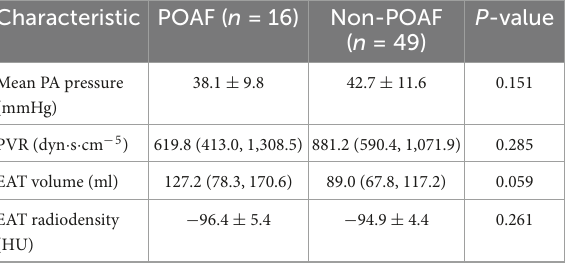
TABLE 2 Univariate analysis of risk factors for POAF in the training/validation